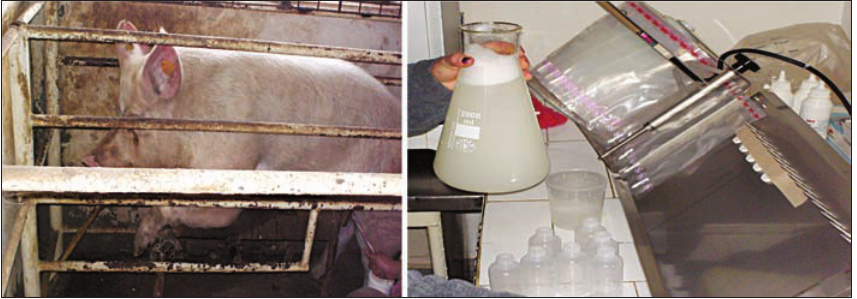
Fig. 2. Semen collection and dillution